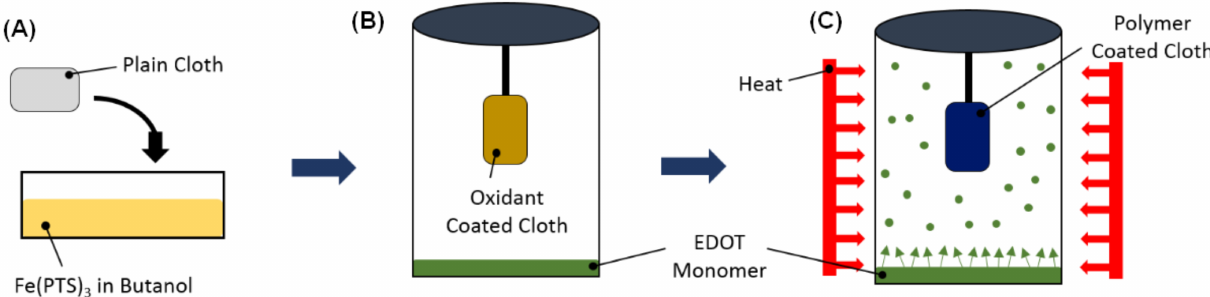
Figure 1. Schematic of vapor-phase polymerization (VPP) process for synthesis of PEDOT films on polypropylene–cellulose fabric. ( A ) The oxidant solution is a mixture of iron(III) p-toluenesulfonate hexahydrate (Fe(PTS) 3 ) in butanol. The fabric is coated by soaking in the oxidant solution. ( B ) The oxidant coated fabric is placed in a sealed container with the monomer. ( C ) Heating the container in a furnace causes the monomer to vaporize and polymerization occurs on the